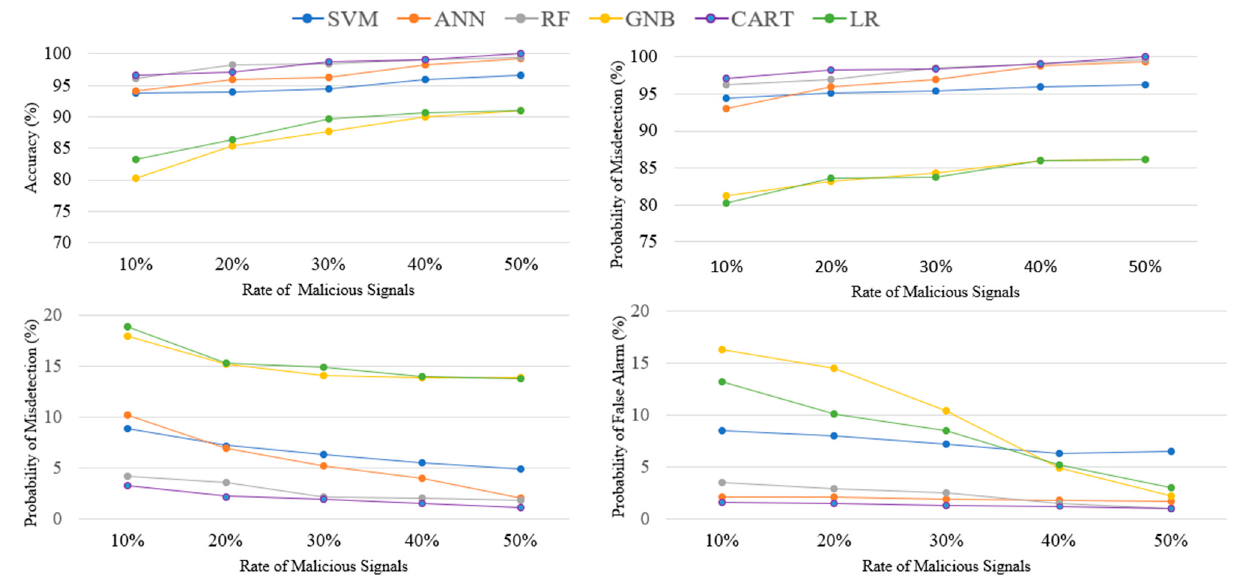
Figure 8. Impact of class imbalance on model performance.